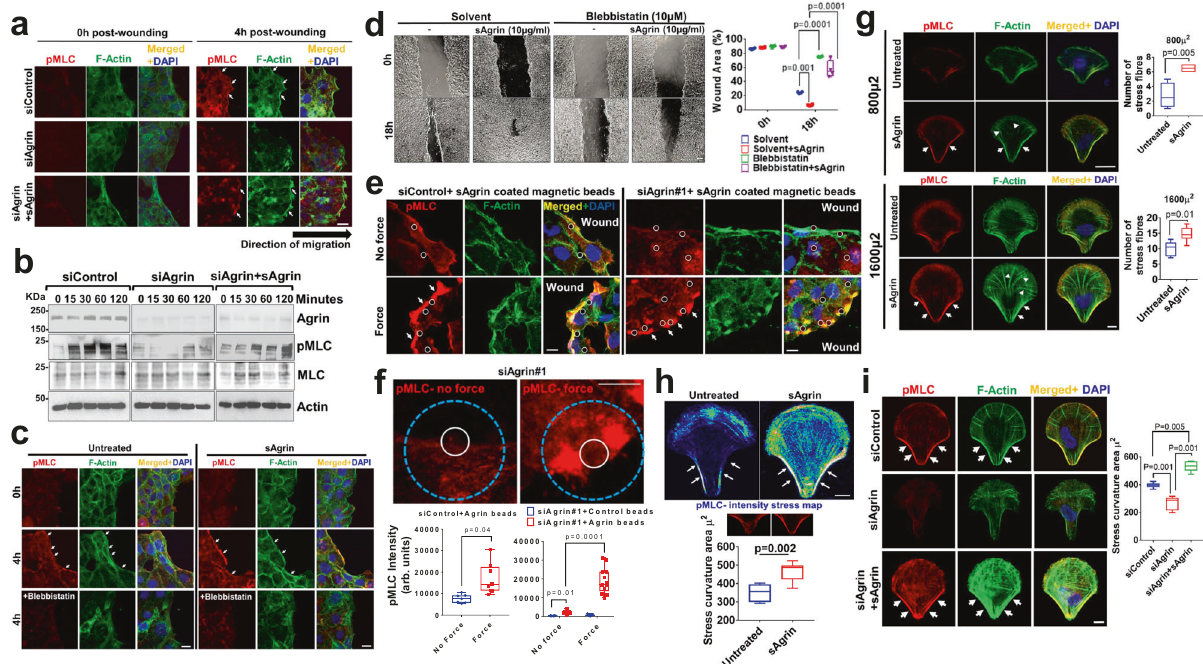
Fig. 4 Agrin tunes cell mechanics during wound injury. a Confocal images showing pMLC and F-Actin staining in control HEK, Agrin depleted and rescued with 10 μ g/ml sAgrin at the indicated time post-scratch. Scale: 10 μ m. White arrows show acto-myosin cables. b Western blot analysis in HEK treated as in ( a ) post-scratch injury after the indicated time ( n = 3 biological repeats). c , d Confocal images of pMLC, F-Actin, and DAPI in untreated or sAgrin nourished HEK in the presence or absence of blebbistatin treatment (2 h). Scale: 10 μ m ( c ). Bright- fi eld images of migrating cells at 18 h post-scratch ( d ). Wound area is plotted in box-whiskers ( n = 3, two-tailed Students ‘ t ’ test, ** p = 0.001, *** p = 0.0001 respectively, Box-1-99 percentile, whiskers- minimum to maximum, central line-median). Scale: 100 μ m. e Confocal images showing pMLC, F-Actin, and DAPI staining under normal or magnetic force- recognition by BSA or sAgrin beads in Control and Agrin depleted HEKs. Scale: 10 μ m. White circles indicate beads. White arrows indicate